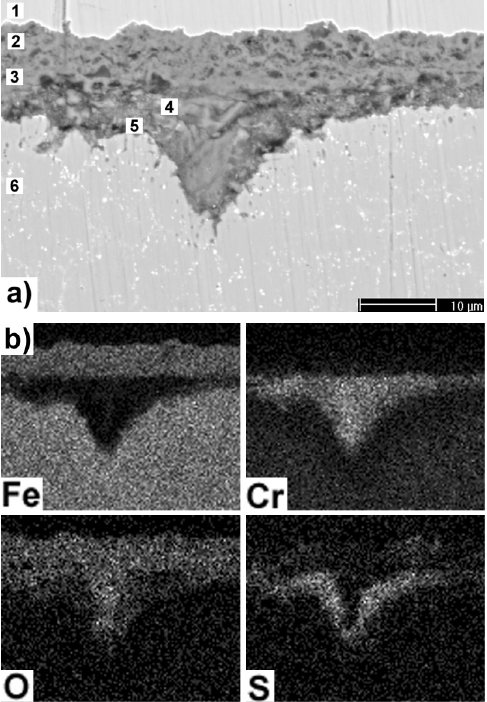
Figure 18. Cross-section of uncoated P91 after 336 hours (cid:3) (cid:3) 15 % H 2 O (cid:3) 13 % O 2 . at 833 K in N 2 (cid:3) 100 ppmv SO 2 2 a) BSE-image. 1) Nickel coating. 2) Fe 2 O 3 . 3) Cr-rich layer. 4) Layer in which S can be found. 5) Substrate.